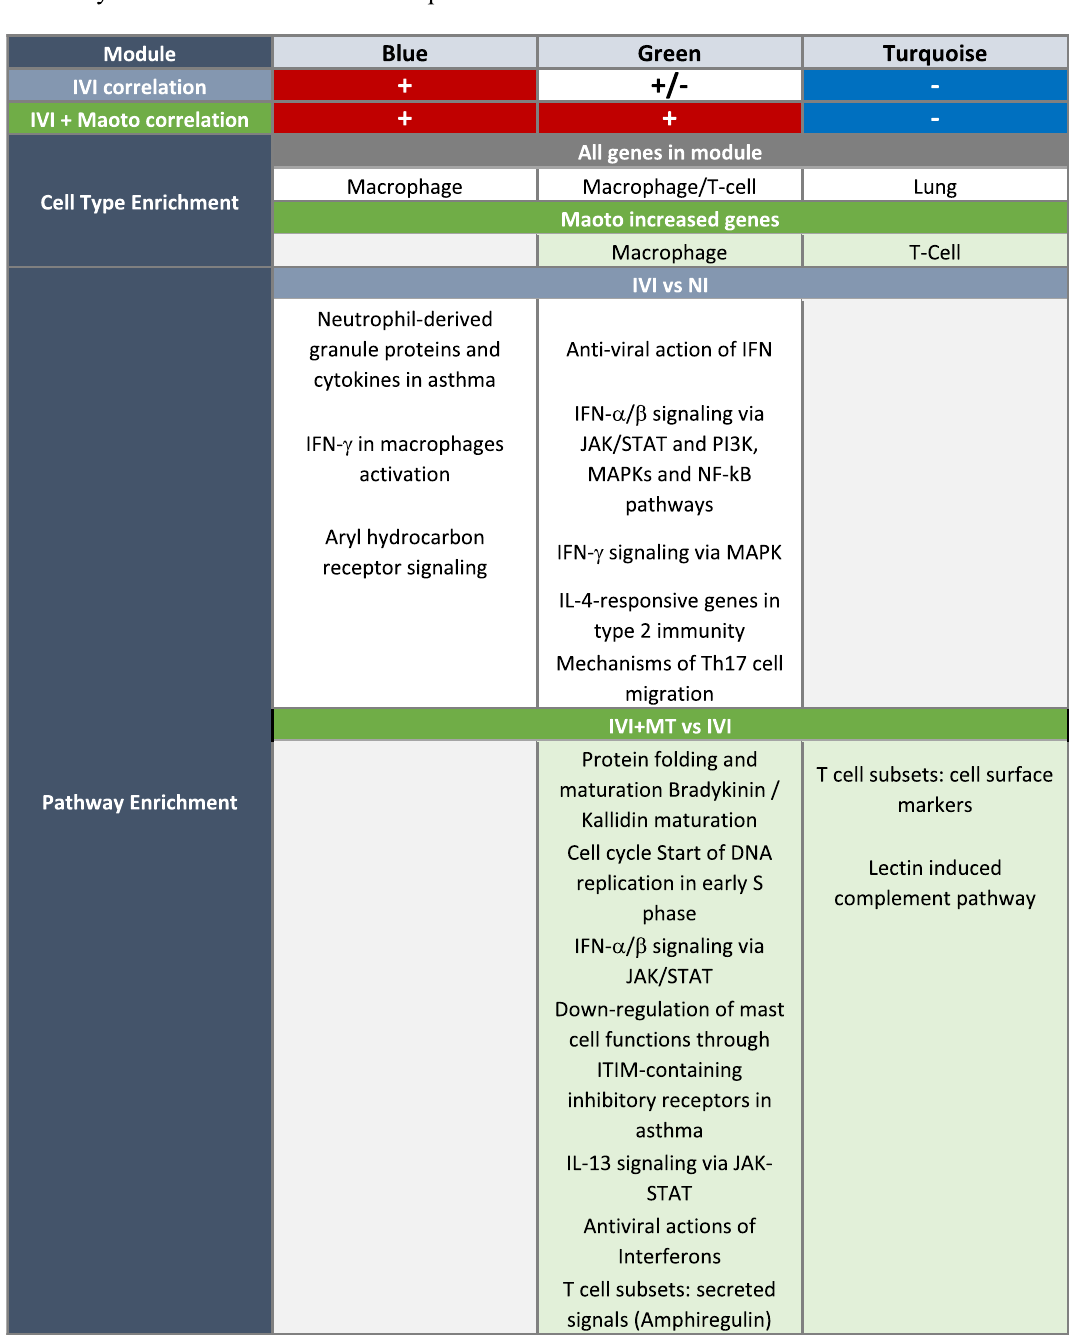
Table 1. Summary of effect of maoto on host response in influenza virus